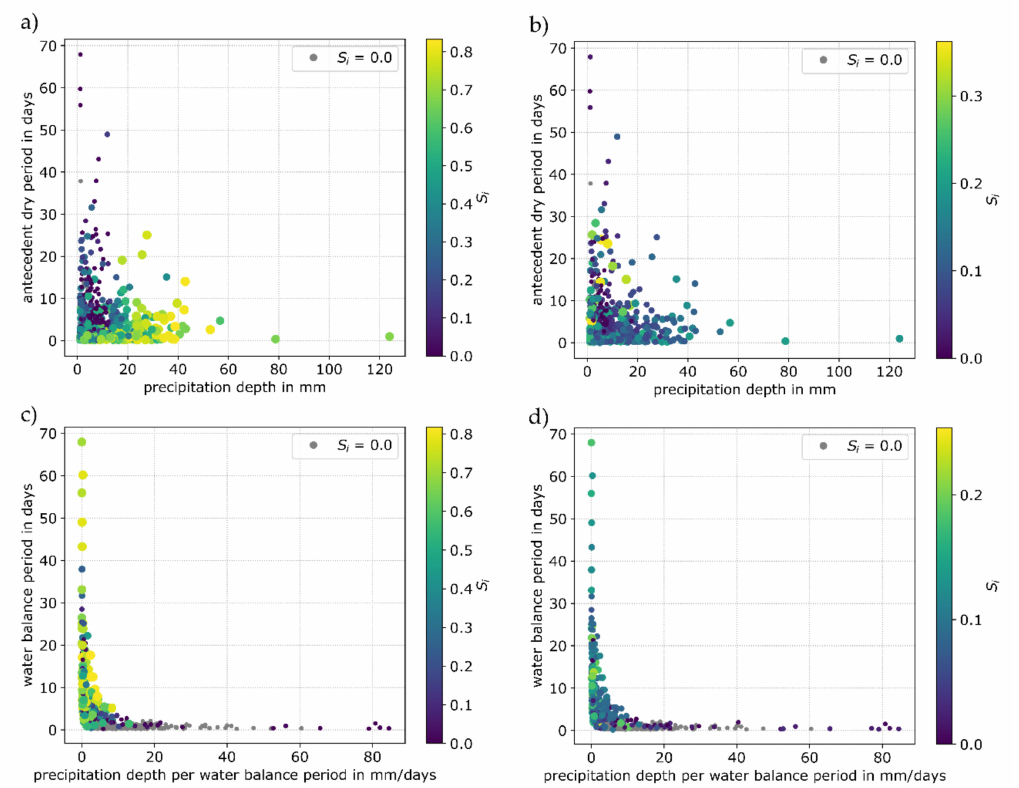
Figure 6. Results of the storm event-based sensitivity analysis for the green roof. Si depending on storm event characteristics ( a + b : Precipitation depth—antecedent dry period, c + d : Water balance period—precipitation depth per water balance period) and green roof parameters. ( a ) Si for runoff volume and soil thickness ; ( b ) Si for runoff volume and porosity ; ( c ) Si for evapotranspiration and soil thickness ; ( d ) Si for evapotranspiration and porosity . Water balance period: Period from start of a storm event to the start of the subsequent storm